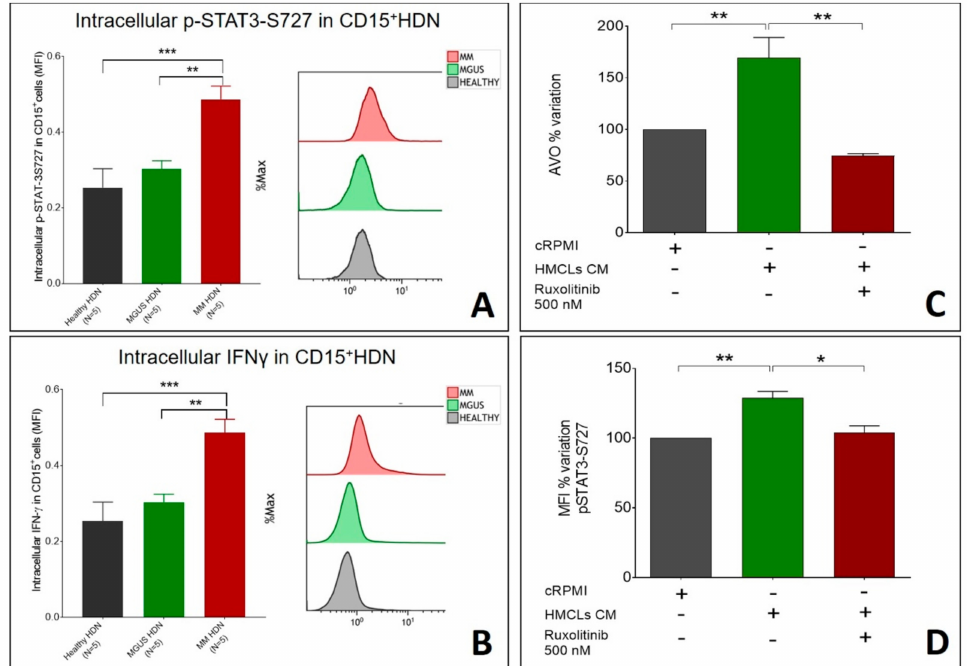
Figure 5. Ruxolitinib can hamper the increase of intracellular IFN γ and p-STAT3-S727 induced by MM soluble factors in HDNs. ( A ) Intracellular interferon-gamma levels, as detected by flow cytometry, in healthy, MGUS, and MM HDN cells are shown, with a representative flow cytometry image for each disease status. ( B ) Intracellular p-STAT3-S7272 levels, as detected by flow cytometry, in healthy, MGUS, and MM HDN cells are shown, with a representative flow cytometry image for each disease status. HDN isolated from healthy subjects were cultured in vitro or 3 h in the presence of conditioned media obtained from MM1.s or U266 cell lines with or without pan-JAK inhibitor 500 nM Ruxolitinib to assess autophagy, detected as the percentage of AVOs after treating with ( C ) and changes in phosphorylation of STAT3 on S727 ( D ). *** p < 0.0001; ** p < 0.001; * p < 0.05 (Student’s t